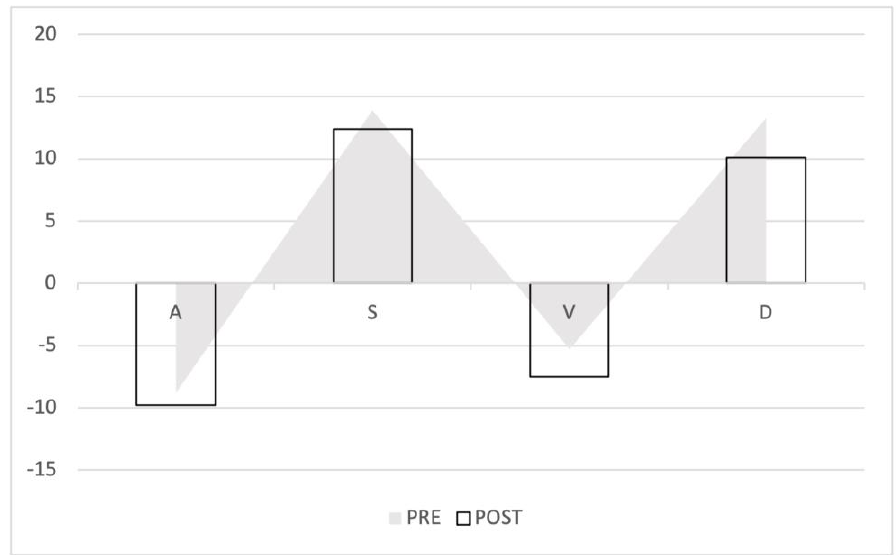
Figure 8. Waveform changes in the retrograde VTI growth group. The triangles represent the preoperative waves, the columns the postoperative waves. The anterograde waves (S and D) decreased, the retrograde flow increased (A and V).